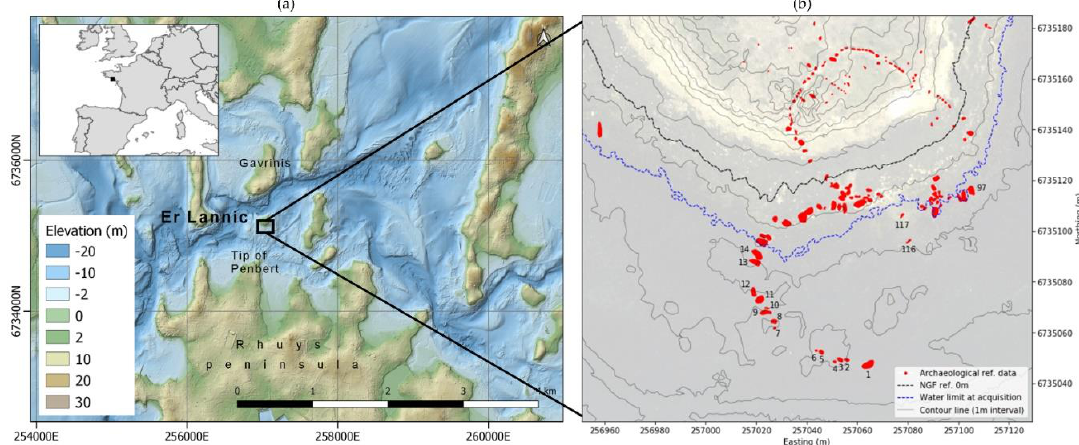
Figure 1. ( a ) Location of the study area (Er Lannic islet, Morbihan, France), ( b ) the archaeological reference data (submerged steles are numbered).